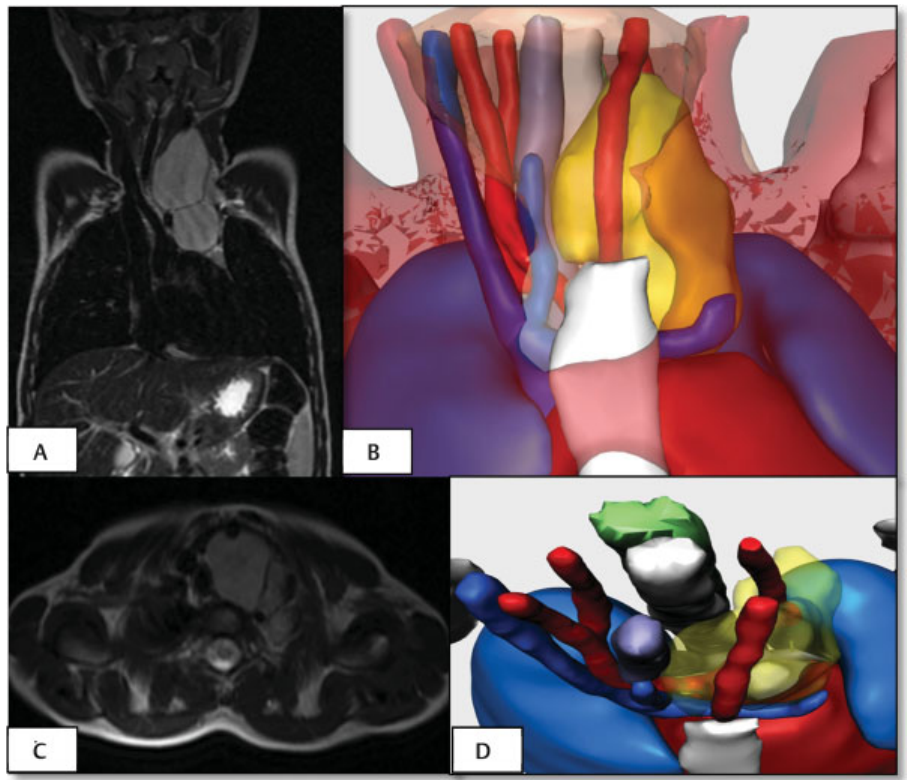
Fig. 7 Case 4. Virtual reconstruction of cervicothoracic paravertebral ganglioneuroma and comparison with images obtained by MRI (A-B coronal view, C-D transverse view). The tumor displaces the left carotid artery, the internal jugular vein, and the airway. The vertebral artery is encased by the tumor. MRI, magnetic resonance